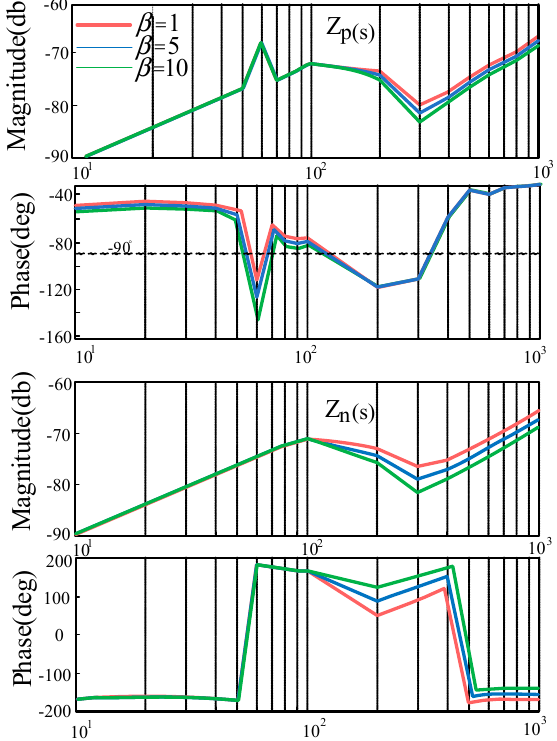
Figure 11. Frequency responses of output impedance as β changes.